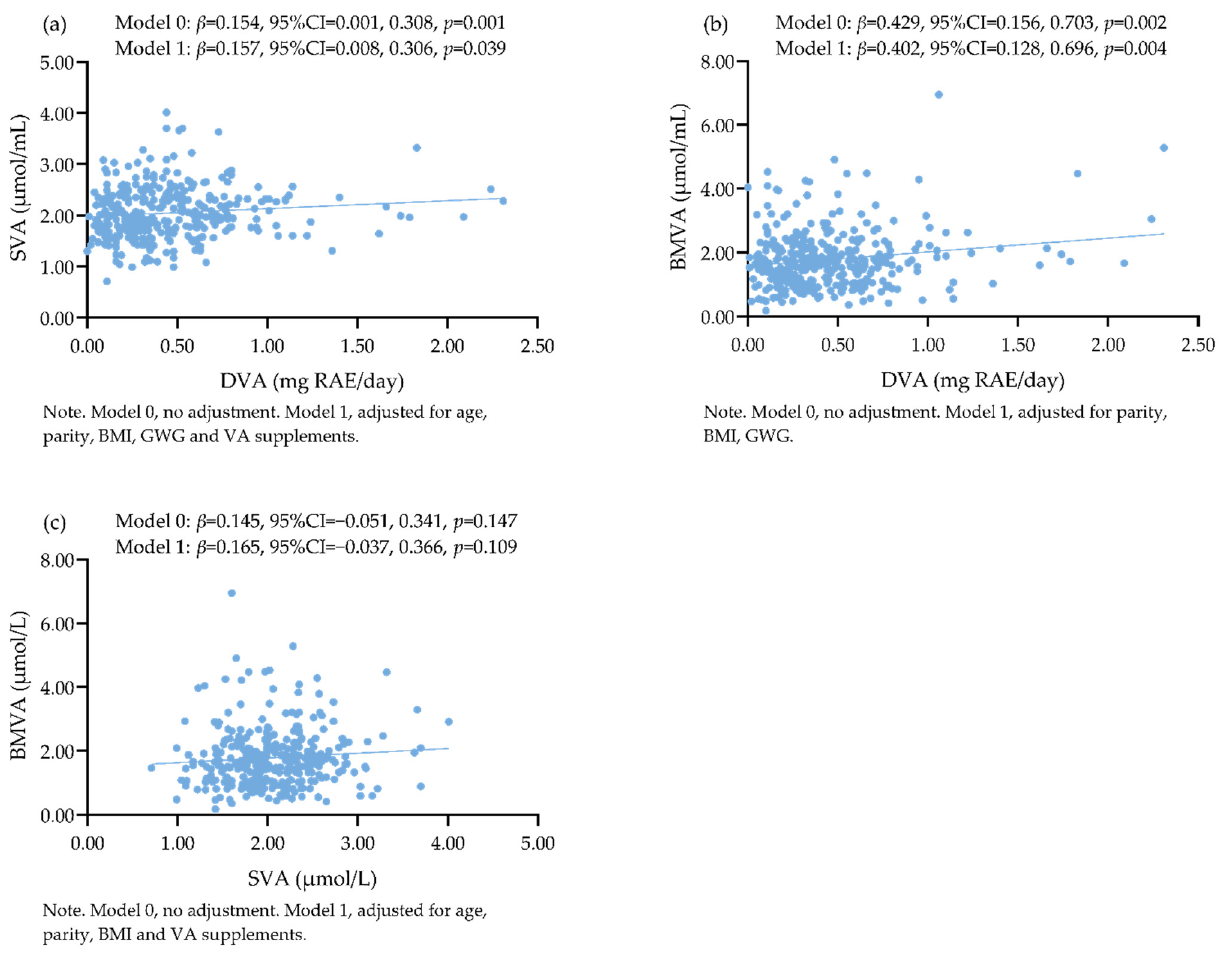
Figure 3. ( a ) Associations between DVA and SVA; ( b ) Associations between DVA and BMVA; ( c ) Associations between SVA and BMVA.